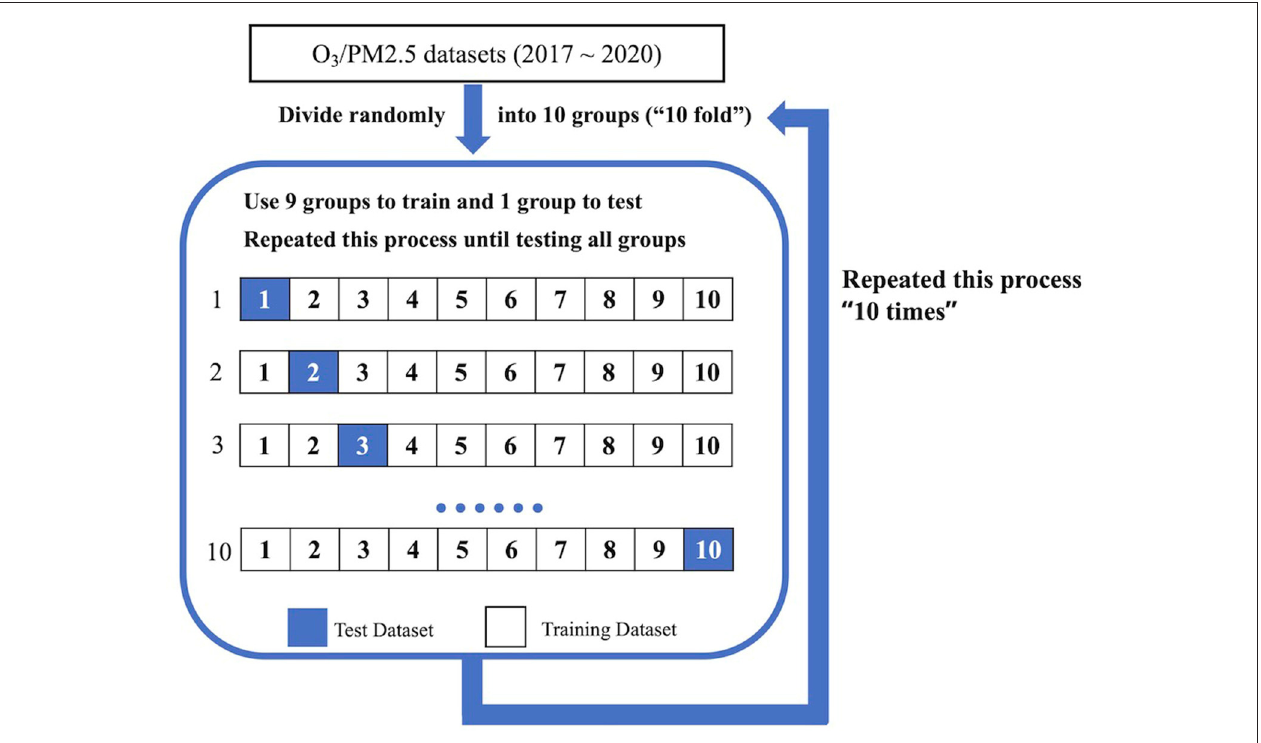
FIGURE 4 | Diagram of 10-time, 10-fold cross-validation.